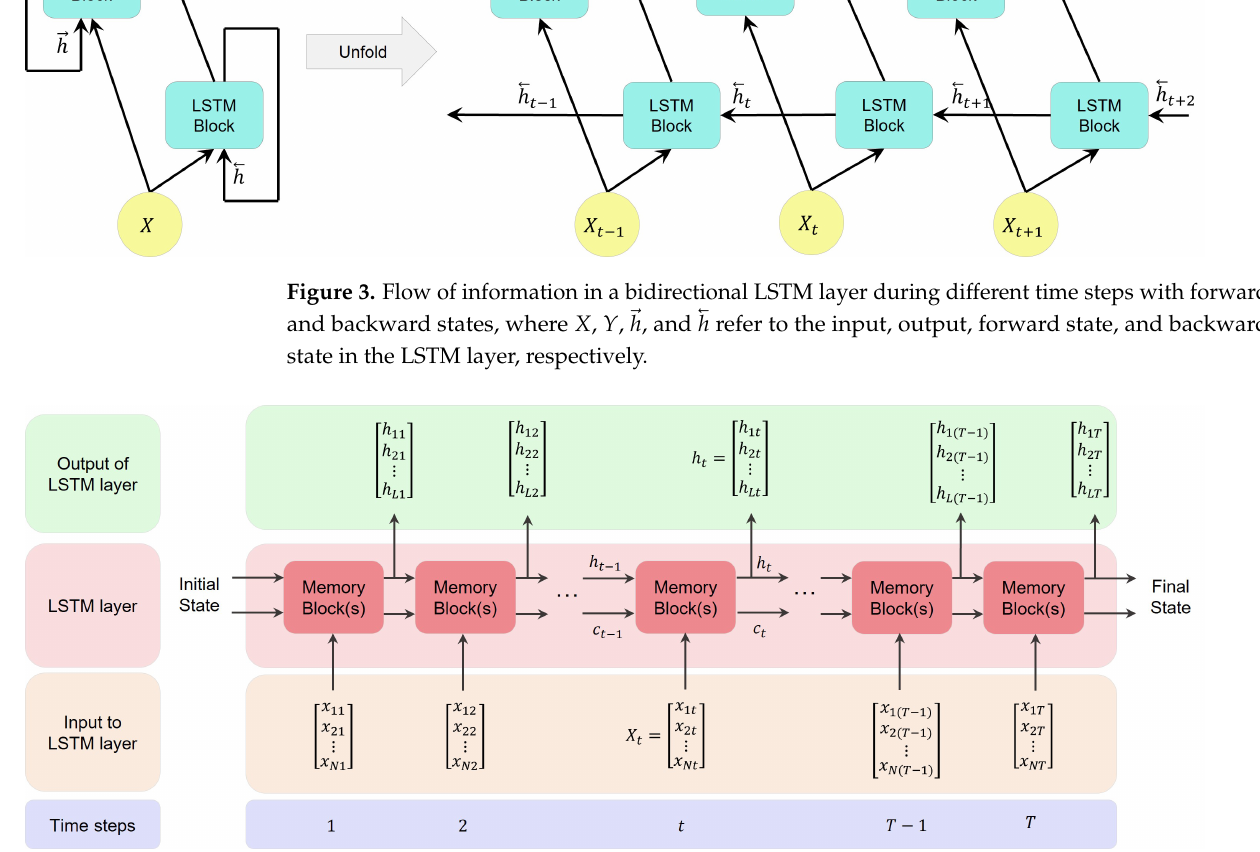
Figure 4. An unfolded LSTM layer that presents the flow of information during different time